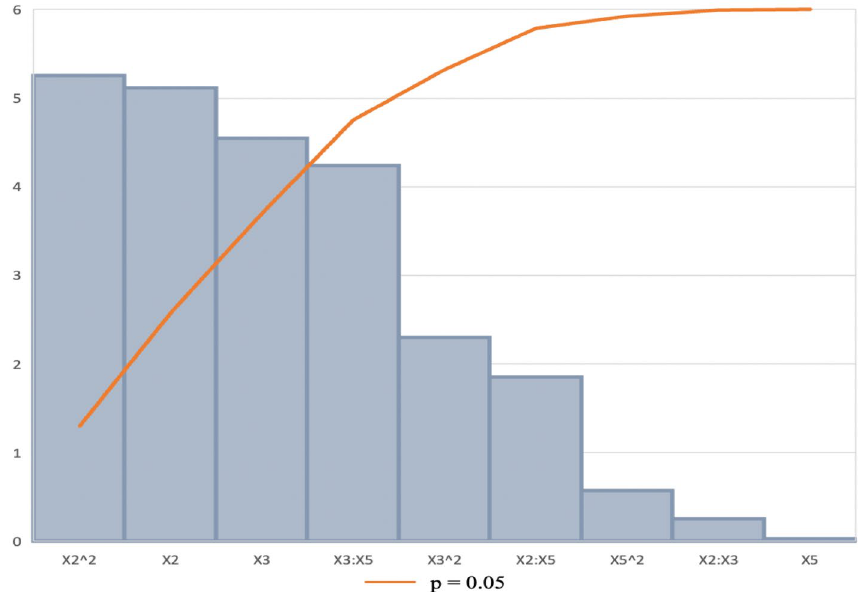
Figure 3. Pareto chart standardized effects of nine interactive factors affecting the production of xylanase optimization. Incubation temperature